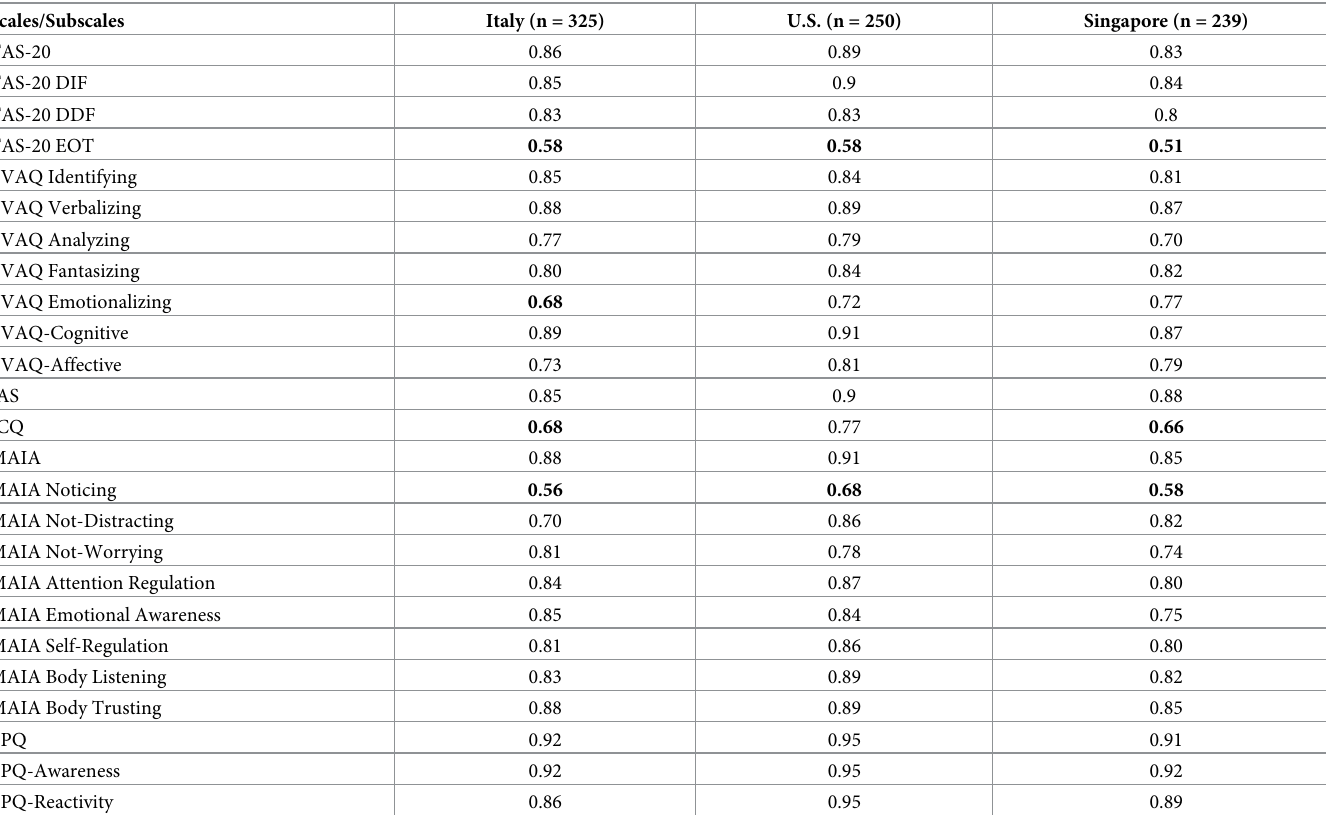
In bold are displayed values under acceptance level ( < 0.70).